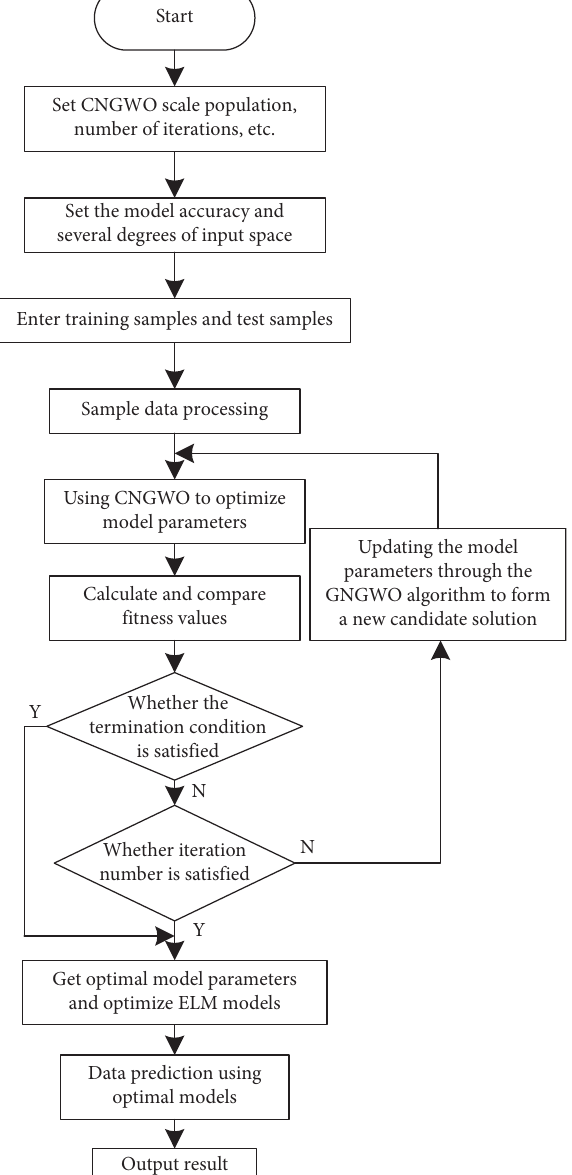
Figure 1: Optimized parameters of ELM by